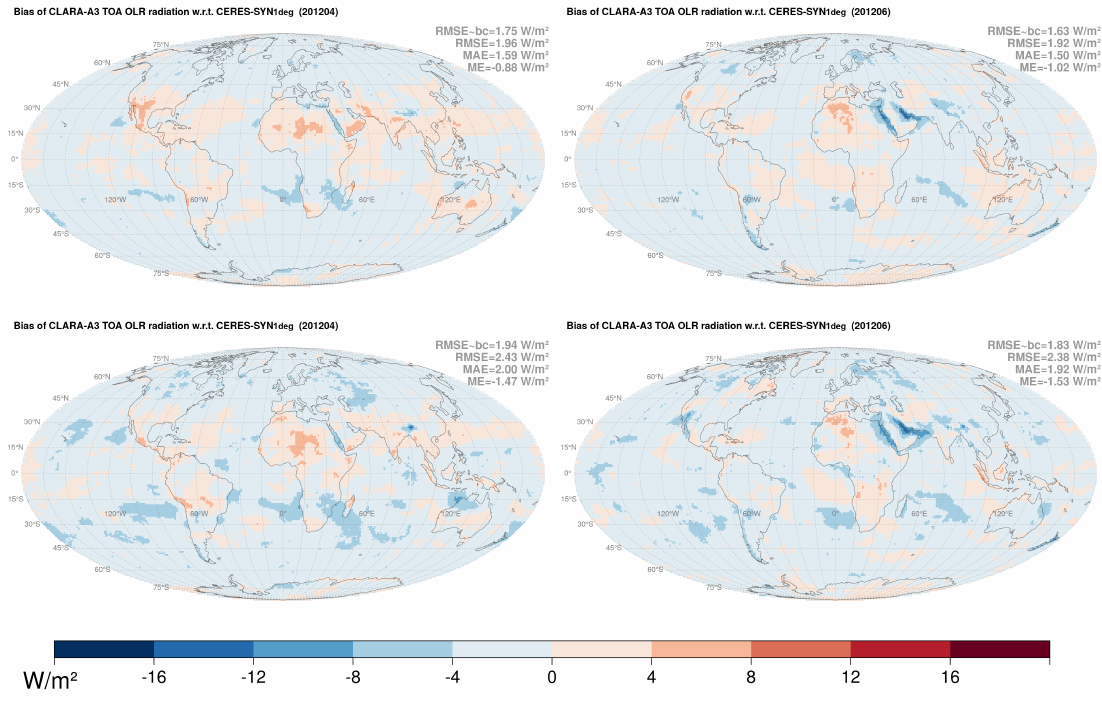
Figure 11. Monthly mean OLR difference with respect to CERES SYN1deg April 2012 ( left ) June 2012 ( right ) when both Channels 4 and 5 are used ( top ) and using only Channel 4 ( bottom